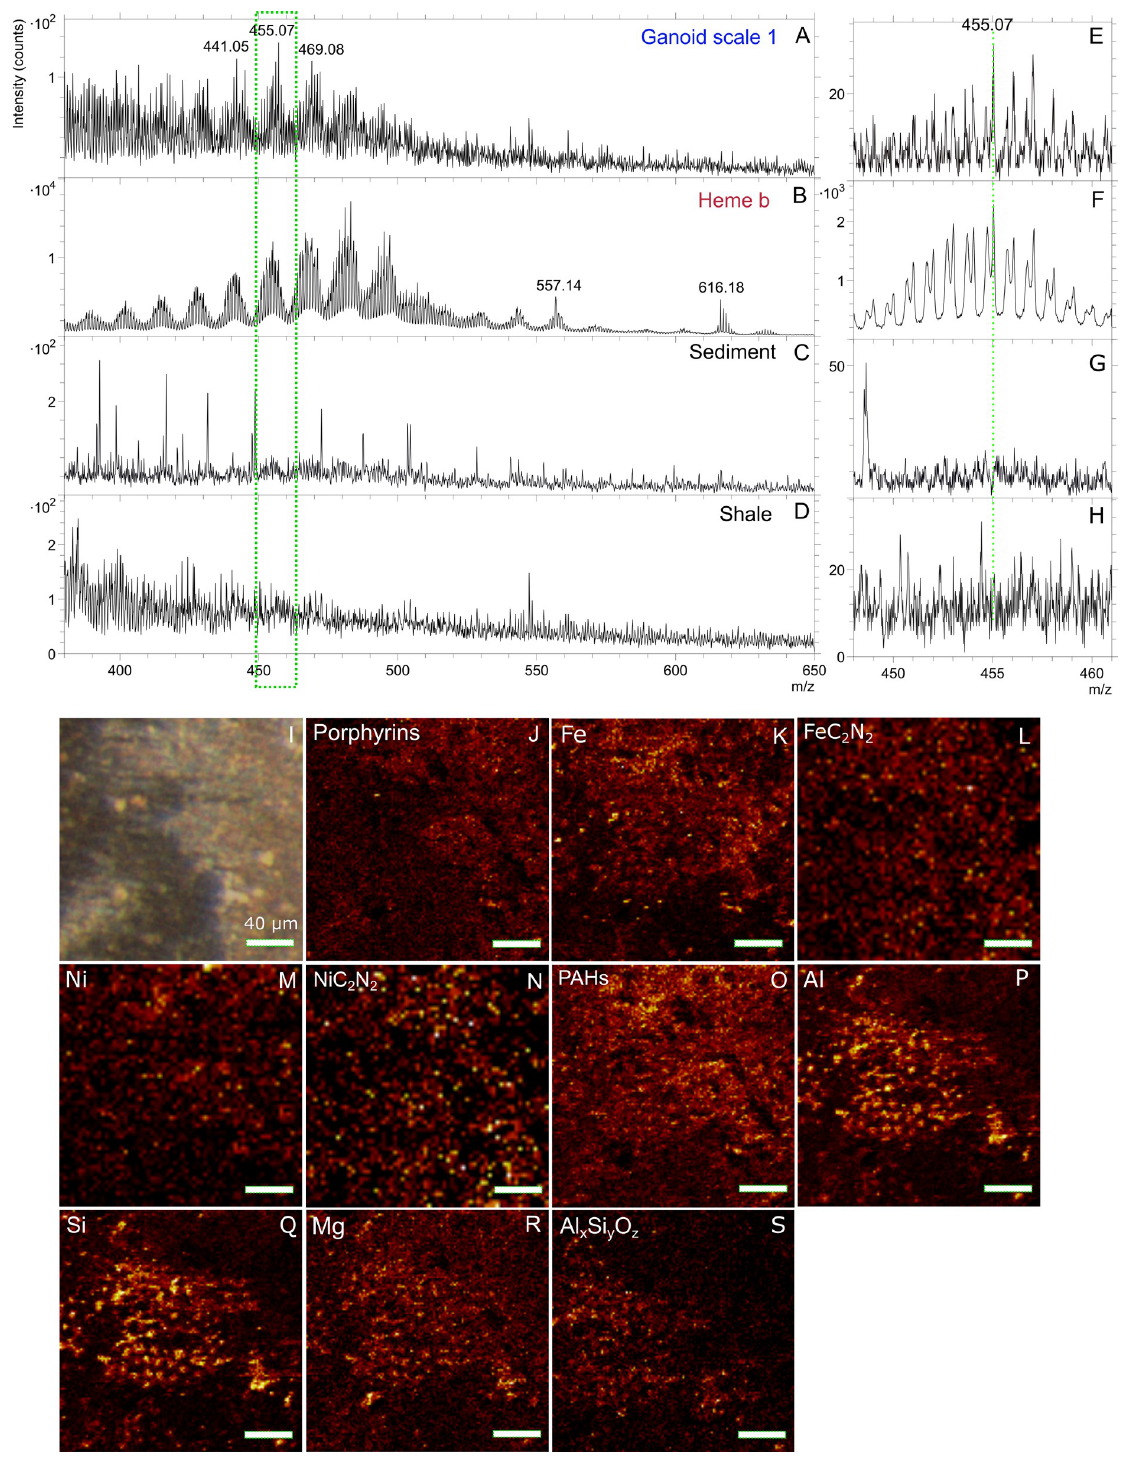
Fig 2. Molecular characterization of gray-brown film on Messel fossil fish scale by ToF-SIMS indicating porphyrins. Positive ToF-SIMS spectra (m/z 380–650) of A) area indicated by green dotted box on ganoid scale 1 in Fig 1B, B) heme b standard, C) sediment attached to scale (S1 Fig) and D) shale sample collected nearby (S1 Fig). E-H) Zoom-in of green dotted box in spectra in A-D showing m/z 448–461. I) Micrograph of area in green dotted box in Fig 1B. High spatial resolution ToF-SIMS ion images of J) sum of porphyrin peaks (m/z 434–447, 449–461, 462–473 and 474–485), K) Fe + , L) FeC 2 N 2- , M) Ni + , N) NiC 2 N 2- , O) sum of PAH:s (m/z 77, 91, 139, 141 and 165), P) Al + , Q) Si + , R) Mg + and S) sum of AlSiO 4- and AlSi 2 O 6- .